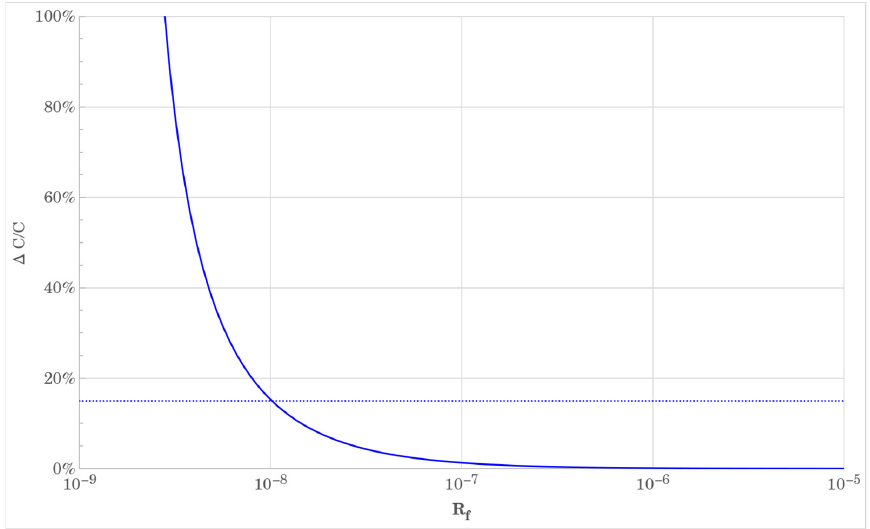
Figure 5. Expected percent upstream–downstream increase in U concentration as a function of the assumed isotopic ratio R f = 236 U/ 238 U. The horizontal blue line represents the upper limit of the observed concentration.